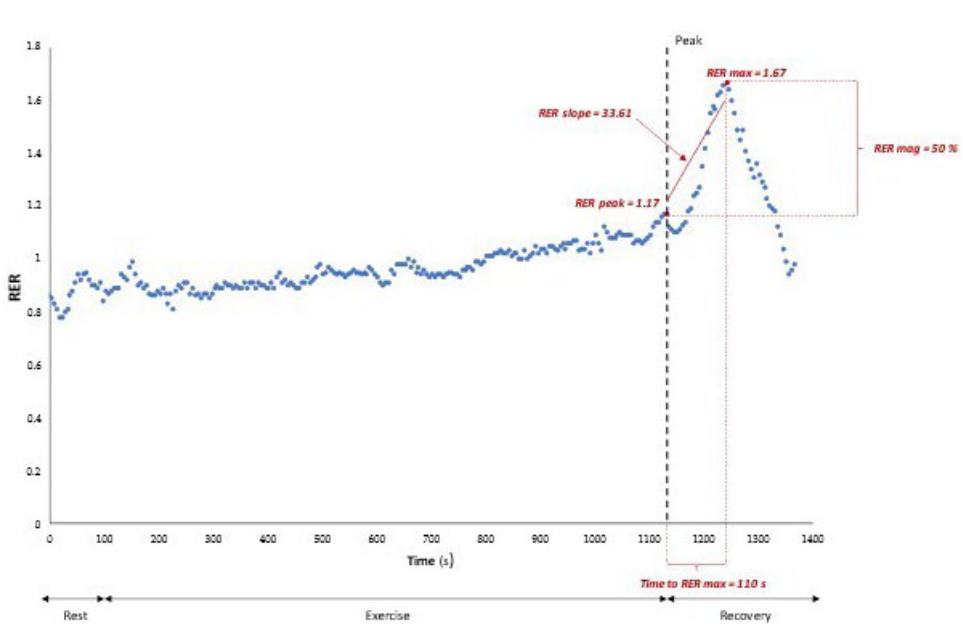
Figure 1. The respiratory exchange ratio (RER) recovery parameters in a healthy subject.